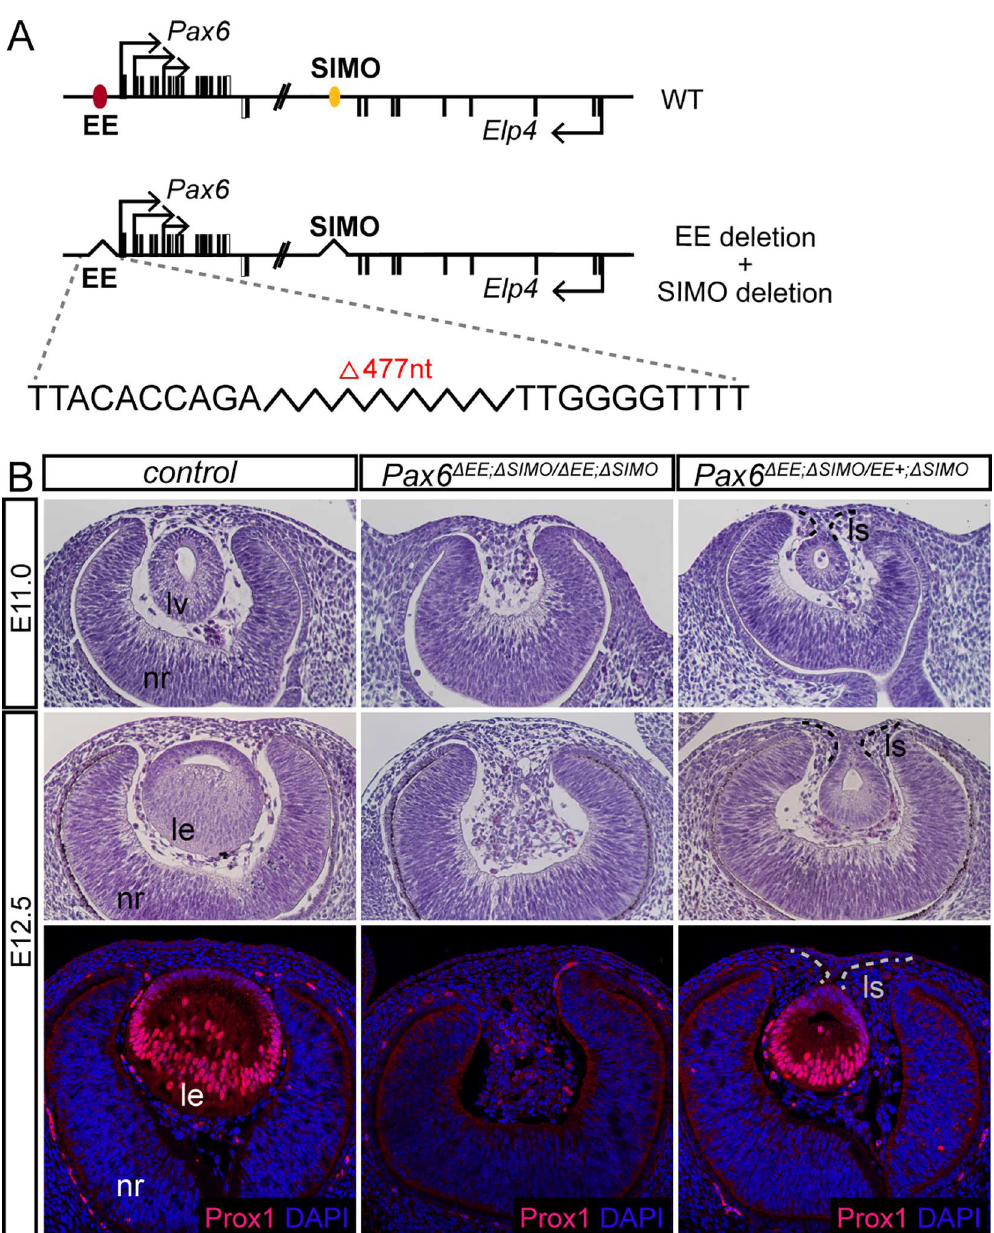
Fig 6. Genetic analysisof the simultaneous deletion of EE and SIMO in vivo . ( A )Schemeof wildtype Pax6 locus,andallelecarryingsimultaneousdeletionof EE andSIMO. EE is indicatedwith red ovalandSIMO with yellow oval. The exactbordersof EE deletionare specifiedby nucleotidesequences flankingthe deletion.( B )Phenotypic consequences of simultaneous deletionof EE andSIMO in Pax6 Δ EE; Δ SIMO/ Δ EE; Δ SIMO embryos.Hematoxylin andeosin stainedparaffinsectionsdemonstrating the arrestedlensdevelopment priorto lenspit stageat E11.0 andabsenceof lensat E12.5 in Pax6 Δ EE; Δ SIMO/ Δ EE; Δ SIMO embryos.Immunoflurescentstainingfor lensmarker Prox1is not detectedin E12.5 Pax6 Δ EE; Δ SIMO/ Δ EE; Δ SIMO embryos.Note that a singlealleleof intact EE in Pax6 Δ EE; Δ SIMO/EE+; Δ SIMO embryosis sufficientfor lensformationalbeitthe resultinglensis muchsmallercompared to control,andlensstalk is apparent. nr—neural retina,lv – lensvesicle,le – lens, ls – lensstalk. (Fig 6B). Immunofluorescent staining for lens marker Prox1 at E12.5 confirmed the absence of lens tissue in Pax6 EE/SIMO double mutant embryos (Fig 6B, the bottom panel). Remarkably, a